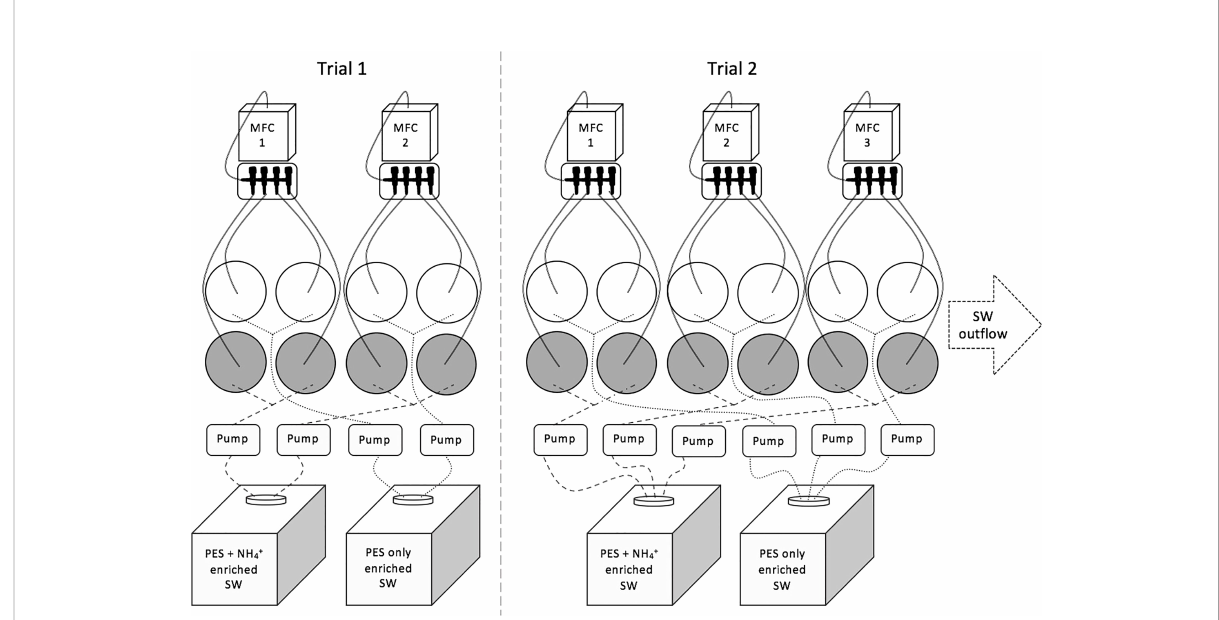
FIGURE 1 Conceptual diagram of experimental set-up. Mass fl ow controllers were connected to N 2 , O 2 , and CO 2 gases. Each mass fl ow controller aerated four culture tanks (grey circles = NH4 + enriched, white circle = non-NH 4+ enriched). Header tanks with 20 L of seawater (SW) with modi fi ed PES and either NH 4 + enriched or not, connected to peristaltic pumps that delivered the SW medium to culture tanks. Each culture tank was connected to seawater out fl ow (connections not shown). Connections to mass fl ow controllers and headers tanks were randomly